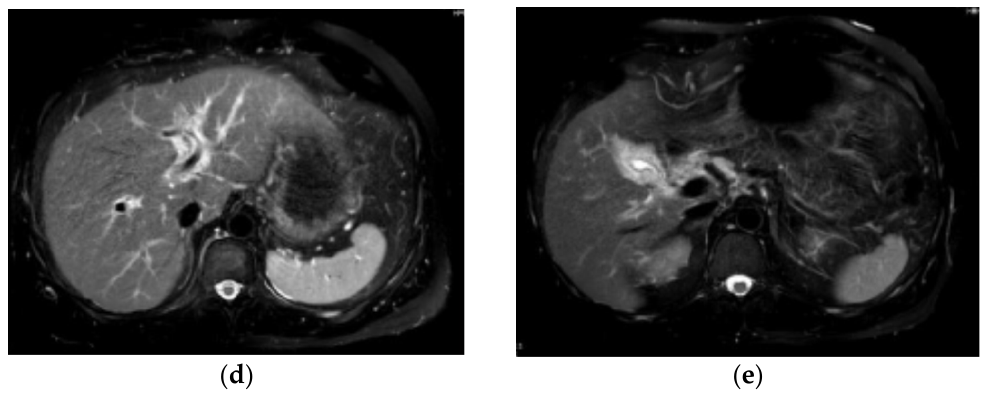
Figure 1. Findings of abdominal ultrasound (US) ( a ), computed tomography (CT) ( b , c ) and magnetic resonance imaging (MRI) ( d , e ) examinations. US indicated acute liver injury with thickening of the gall bladder wall and minimal ascites on the underside of the liver ( a ). The contrast-enhanced CT scan also indicated acute liver injury with thickening of the gall bladder wall ( b , c ). MRI indicated acute liver injury with periportal abnormal intensity ( d ) and thickening of the gall bladder wall ( e ).